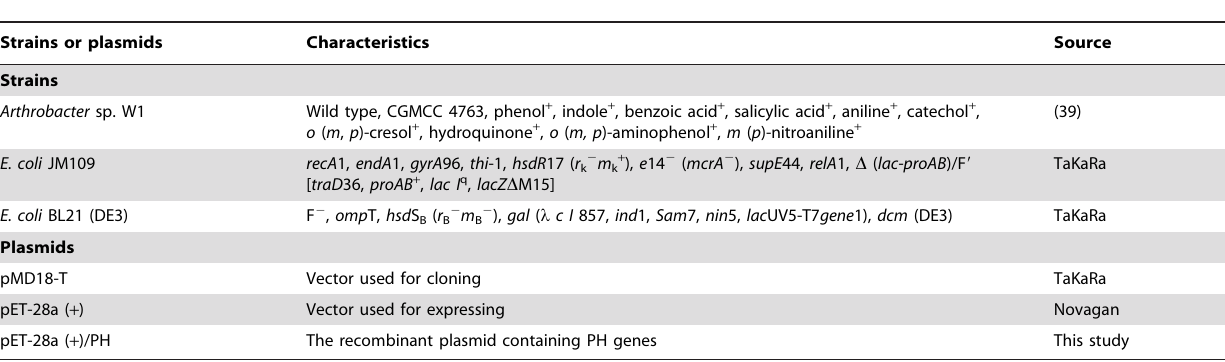
Table 4. Bacterial strains and plasmids used in this